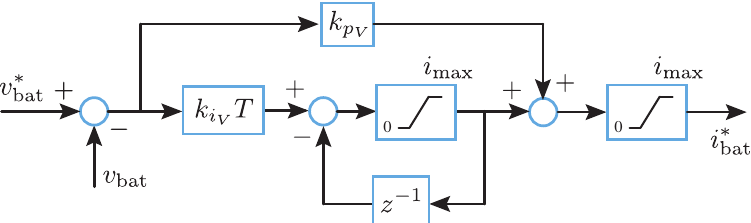
Figure 8. Block diagram of the battery voltage regulation to calculate the battery current